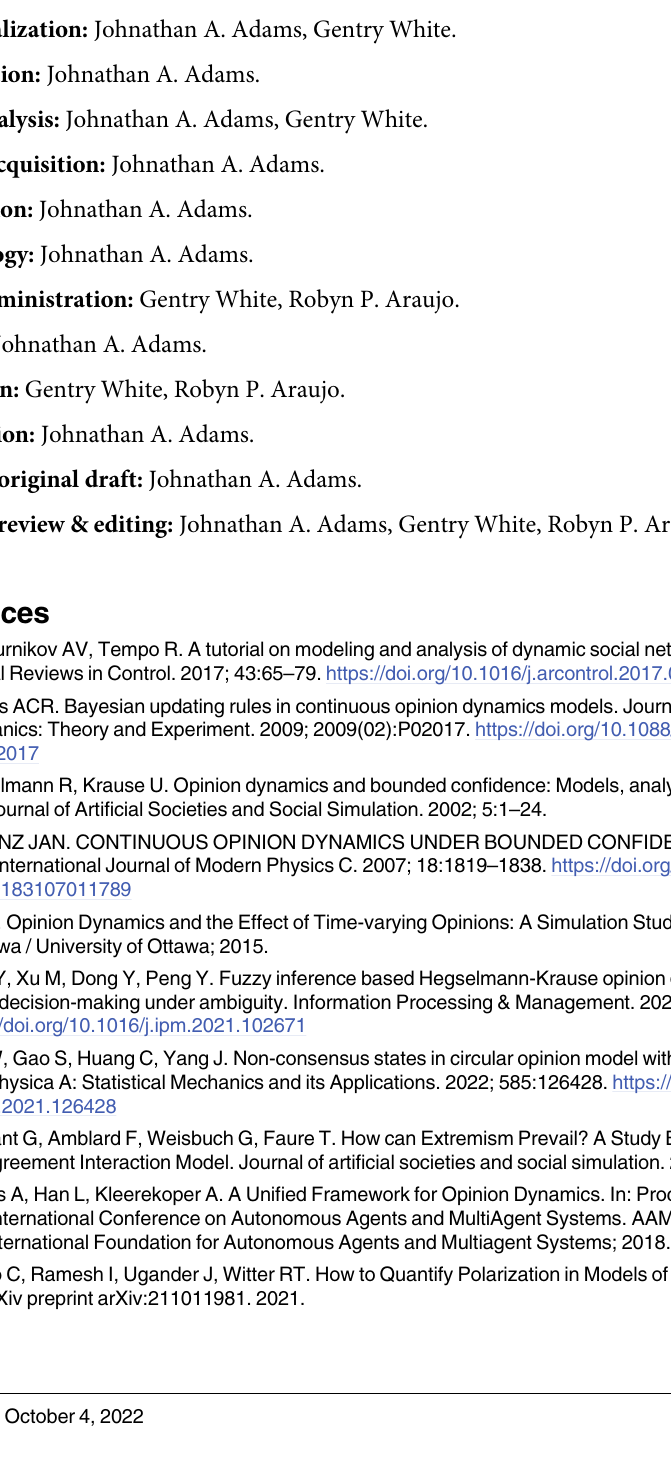
S1 Fig. Alternate min-max flow compared with min-max flow for HK bounded confidence. (TIF) S1